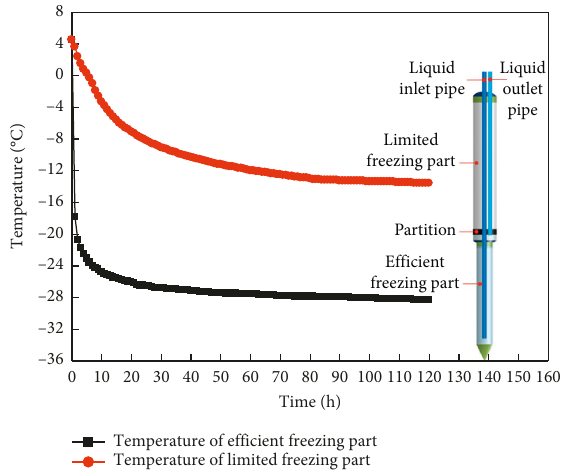
Figure 3: Structure and temperature distribution of a local dif- ferential freezing